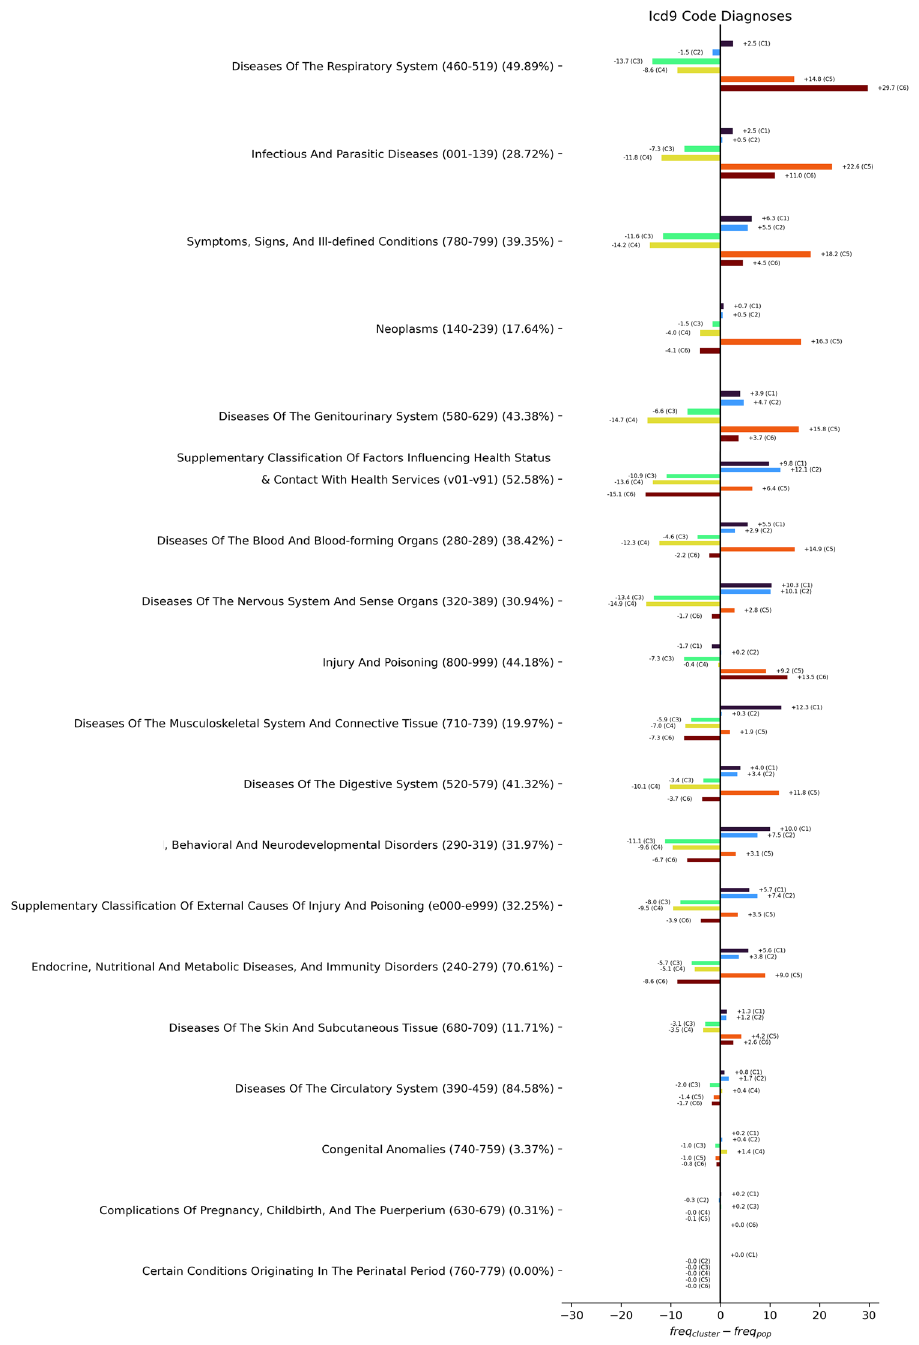
Figure 5. Differences of distribution of ICD categories within the primary clustering ( k = 6 ). For every ICD category, we measure the frequency within the entire population (denoted in parentheses after the category name) and then plot the difference in frequency in different clusters compared to the population frequency. Categories are sorted by the magnitude of the largest difference found within any clusters for the category. Note that since patients may have many diagnoses, clusters can have a higher frequency than the population for many categories (e.g. Cluster